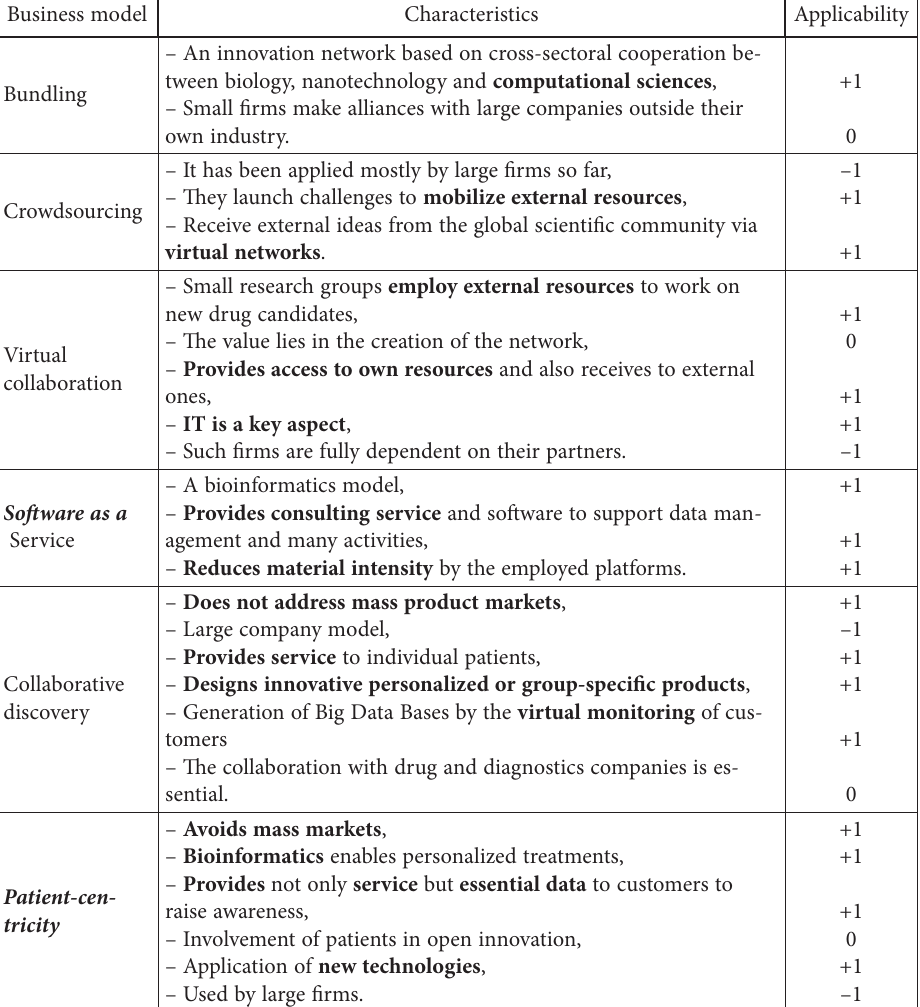
Table 4. Data-driven open business models of the Belgian pharmaceutical biotech industry (source: self-made based on Segers, 2017) Business